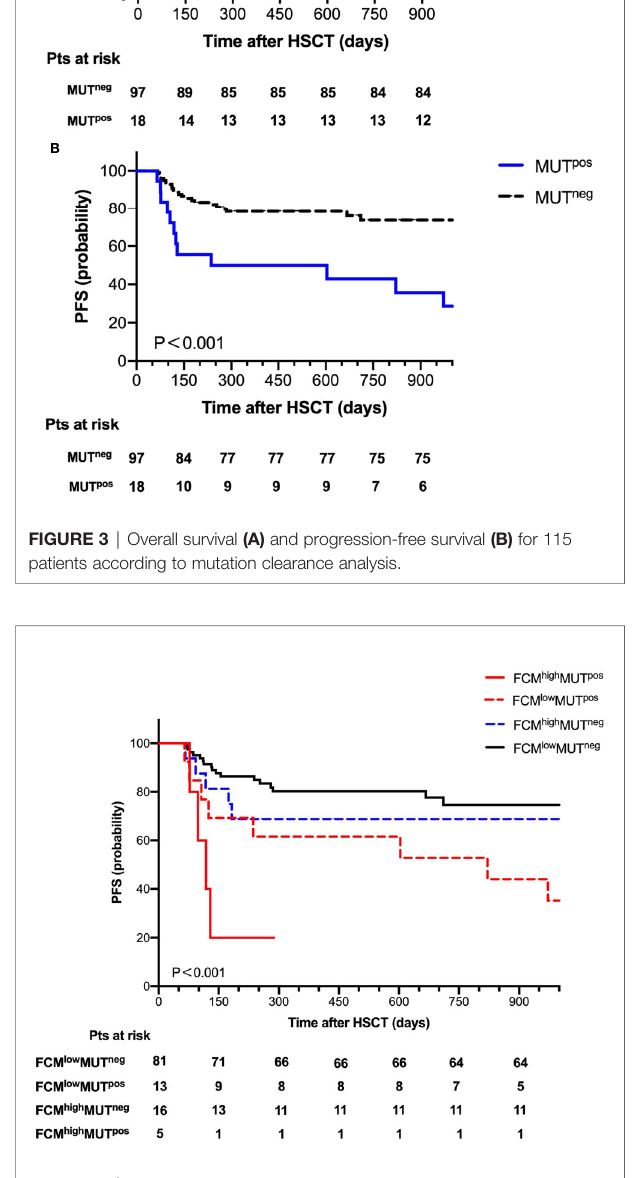
FIGURE 4 | Progression-free survival for 115 patients according to combine FCM MRD with mutation clearance